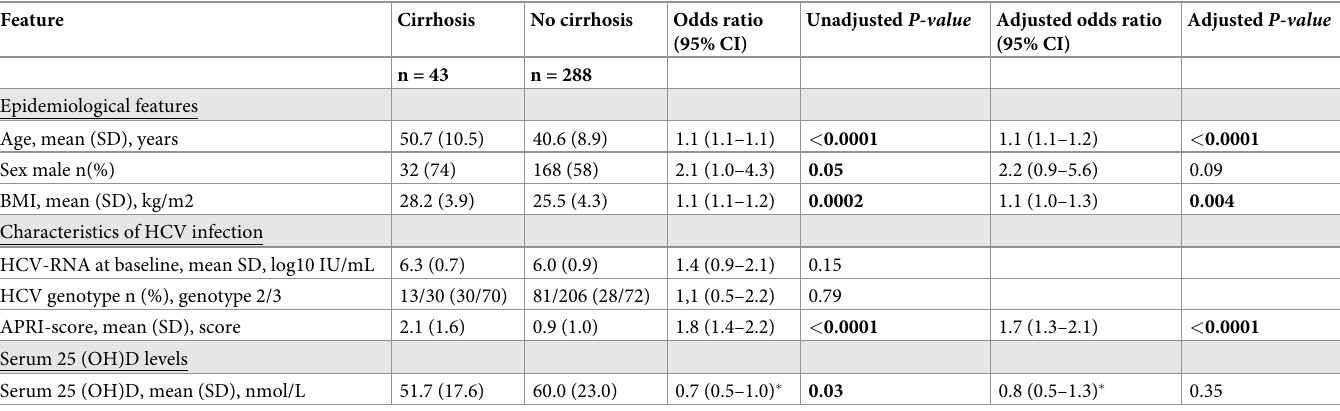
Table 3. Differences in baseline characteristics according to